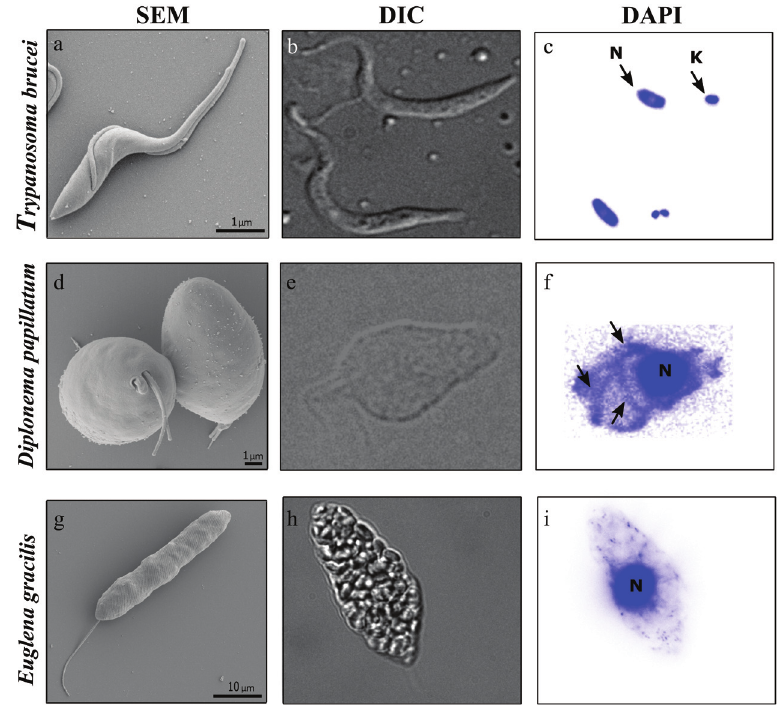
Figure 2. Morphology of representatives of Kinetoplastea ( Trypanosoma brucei ), Diplonemea ( Diplonema papillatum ), and Euglenida ( Euglena gracilis ). Scanning electron microscopy (SEM) ( a , d , g ) and differential interference contrast (DIC) ( b , e , h ) reveal cell morphology, whereas 4 ′ ,6-diamidino-2-phenylindole (DAPI) staining provides information about the amount and distribution of mitochondrial DNA ( c, f, i ). ( c ) Trypanosoma with distinct nucleus (N) and kinetoplast (K). ( f ) In Diplonema , arrows point to large amounts of mitochondrial DNA meandering through the cell. Scale bars = 1 μm ( a , d ) and 10 μm ( g